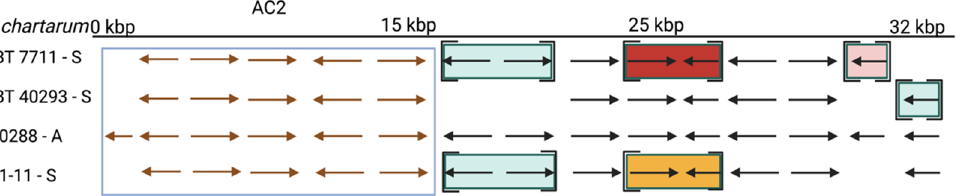
Figure 6. The atranone cluster 2 (AC2) region annotated for S. chartarum strains IBT 7711, IBT 40293, IBT 40288, and 51-11. Arrows indicate genes. The boxed genes represent the AC2 and encode the hypothetical proteins: S40288_09035, S40288_11459, S40288_09036, S40288_09037, S40288_09038, and S40288_11460 (from left to right). Genes in square brackets are not part of the scaffold harboring the AC2 but reside in other scaffolds. An identical coloration indicates affiliation to a common scaffold in the respective strain that is distinct from that harboring the AC2. Table 6. Comparison of the presumed coding sequences of the atranone cluster 2 (AC2) and the respective scaffolds ((IBT 40288: scaffold 123); 51-11: scaffold 4, 5, and 2; IBT 40293: scaffolds 1203, 1206, and 386; IBT 7711: scaffolds 1035, 142, 1199, and 500) (compare Figure 6).